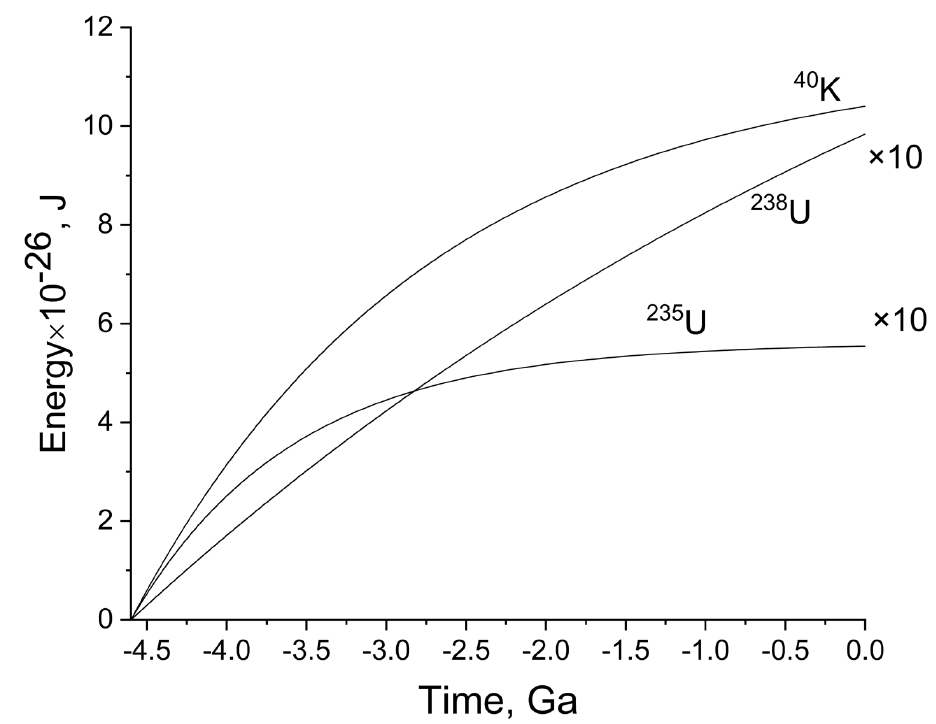
Figure 2. Time dependence of the energy release upon the decay of 40 K, 238 U, and 235 U in the ocean. The decay of isotopes 232 Th, 238 U, 235 U, and 40 K also served as a powerful energy source in the early stage of evolution (the first 500 million years). Therefore, it would be reasonable to expect that natural radioactivity has considerably affected the chemical evolution of the Earth: transformation of matter, oxygenation of the atmosphere, and finally the appearance of